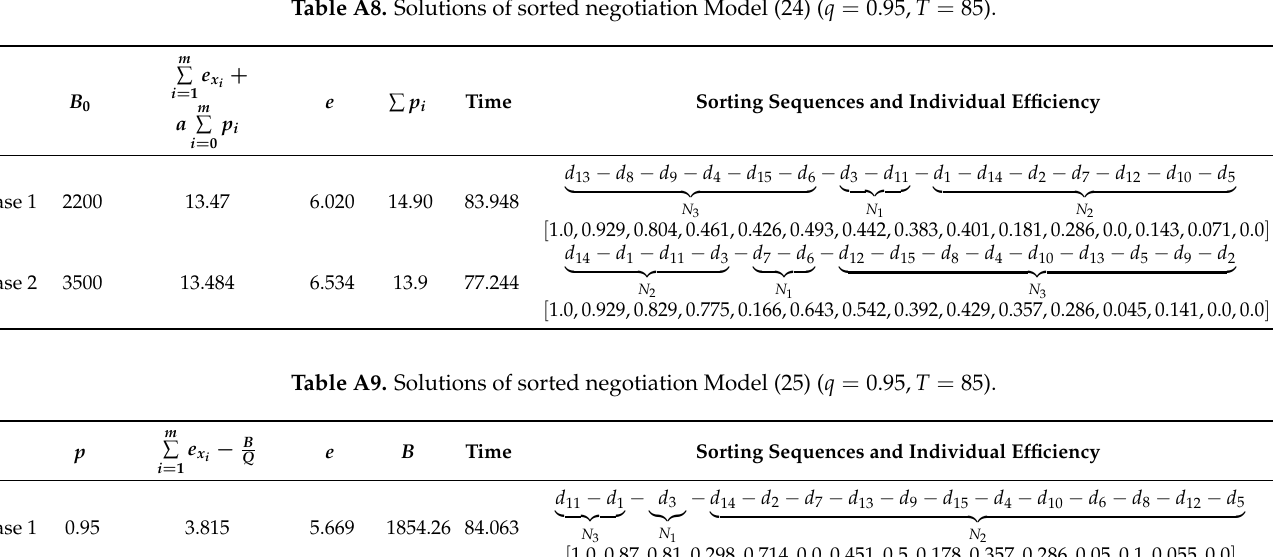
Table A8. Solutions of sorted negotiation Model (24) ( q = 0.95, T = 85).